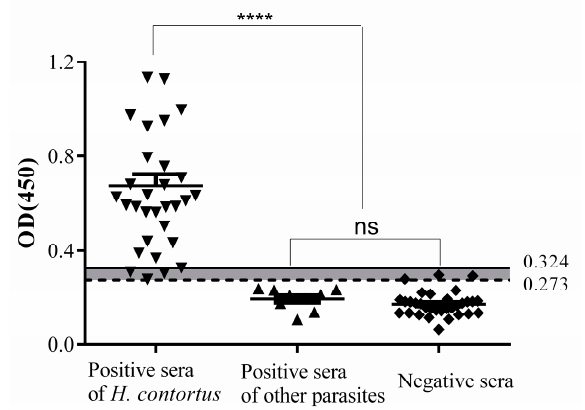
Figure 4. Sensitivity, specificity, and cross-reactivity of the ELISA. The solid horizontal line represents the positive cut-off value (0.324) and the dotted horizontal line represents the negative cut-off value (0.273). Four samples were observed as false negatives and three as false positives. Statistically significant differences were observed between H. contortus -positive sera and the other organisms’ sera ( T. gondii-, F. hepatica- , and T. spiralis -positive) and H. contortus -negative sera. No significant differences were noted between the H. contortus -negative and the other parasite-positive serum